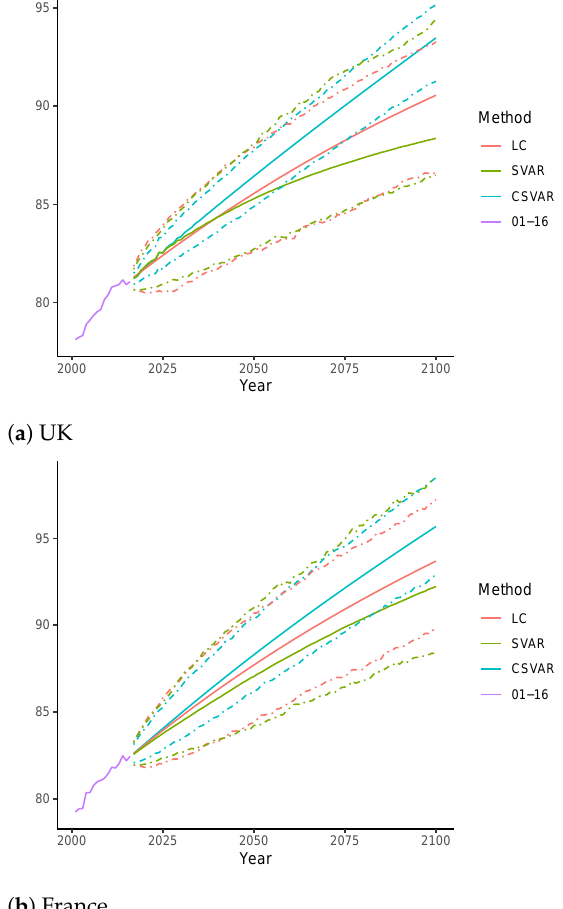
Figure 4. Mean forecast and the 95% prediction intervals vs. actual life expectancy at bitrh: